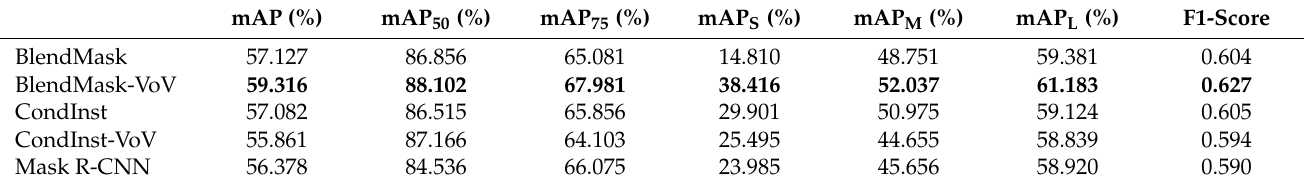
Table 3. Quantitative Evaluation of the validation set in the segmentation